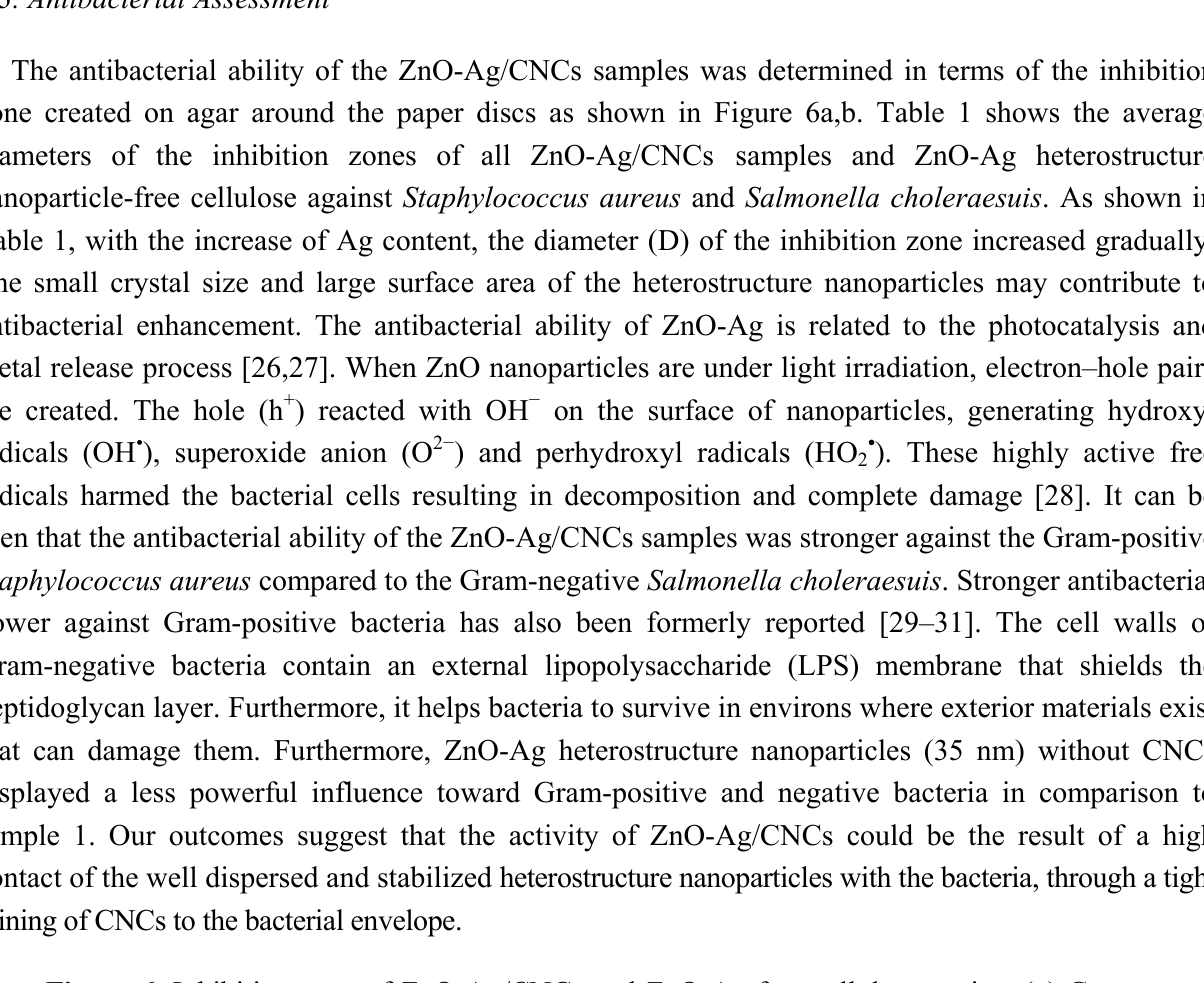
Figure 6. Inhibition zone of ZnO-Ag/CNCs and ZnO-Ag free-cellulose against ( a ) Gram- positive and ( b ) Gram-negative